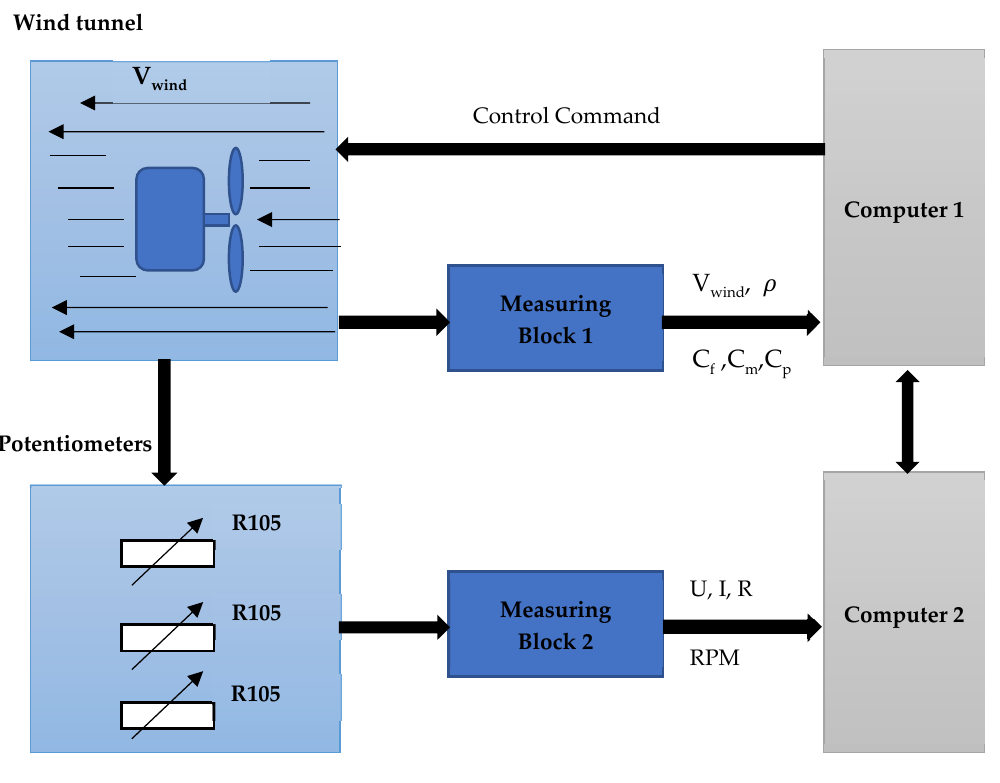
Figure 24. Diagram of the experimental setup.